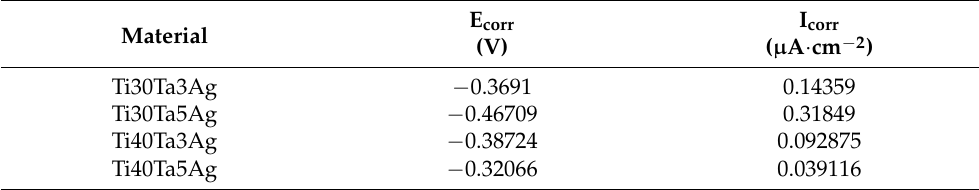
Table 3. Corrosion potential E corr and corrosion current density I corr for the Ti-Ta-Ag alloys.